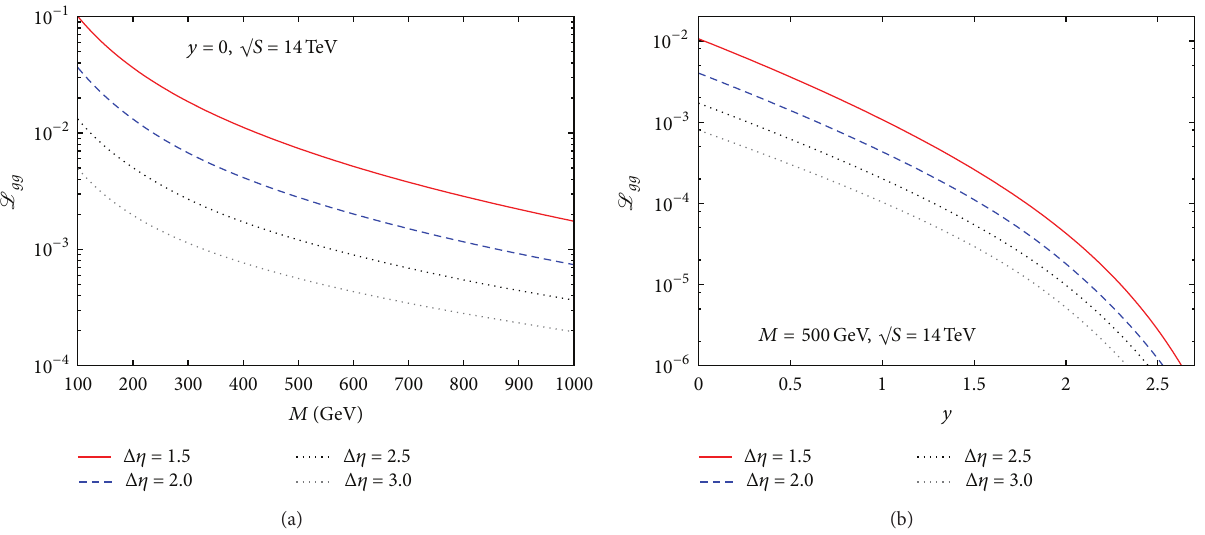
Figure 6: (a) The effective luminosity L 𝑔𝑔 as a function of the invariant mass 𝑀 of the central system produced at 𝑦 = 0 at the 14TeV LHC and (b) L 𝑔𝑔 as a function of 𝑦 for the production of a system with mass 𝑀 = 500 GeV at the 14TeV LHC. For both plots we choose four values of the rapidity gap, that is, Δ𝜂 = 1.5, 2.0, 2.5, and